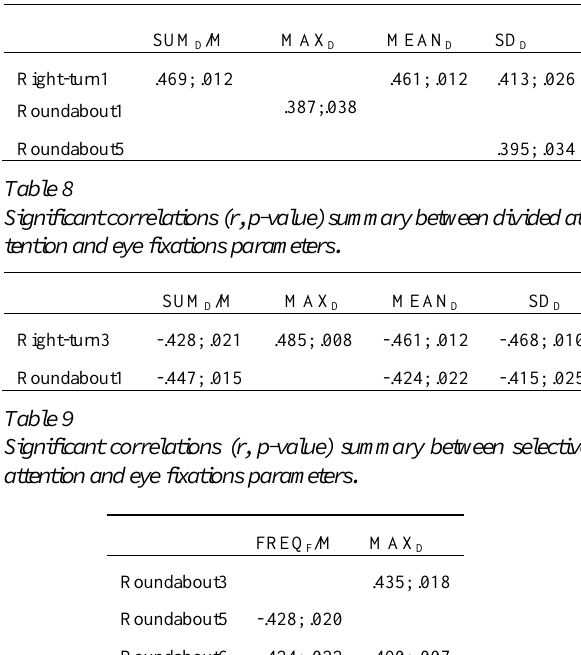
Significant correlations (r, p-value) summary between processing speed and eye fixations parameters.